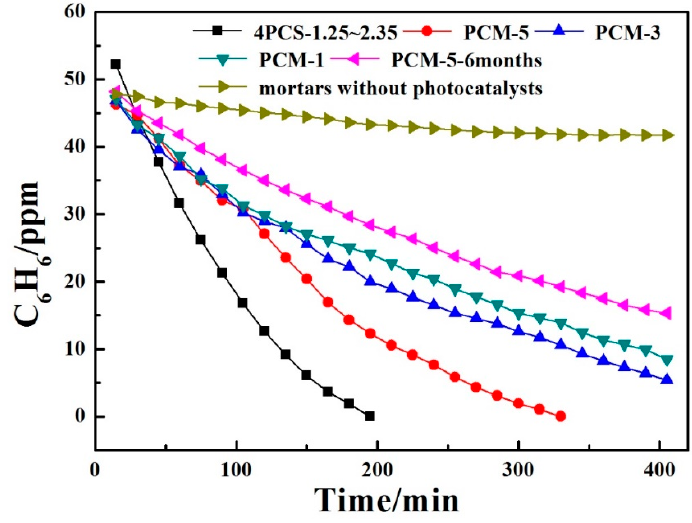
Figure 9. Photocatalytic activity of PCM and mortars without photocatalysts to benzene; PCM-1, 3, 5 (photocatalytic cement materials with 1, 3, 5 g 4PCS-1.25~2.35).